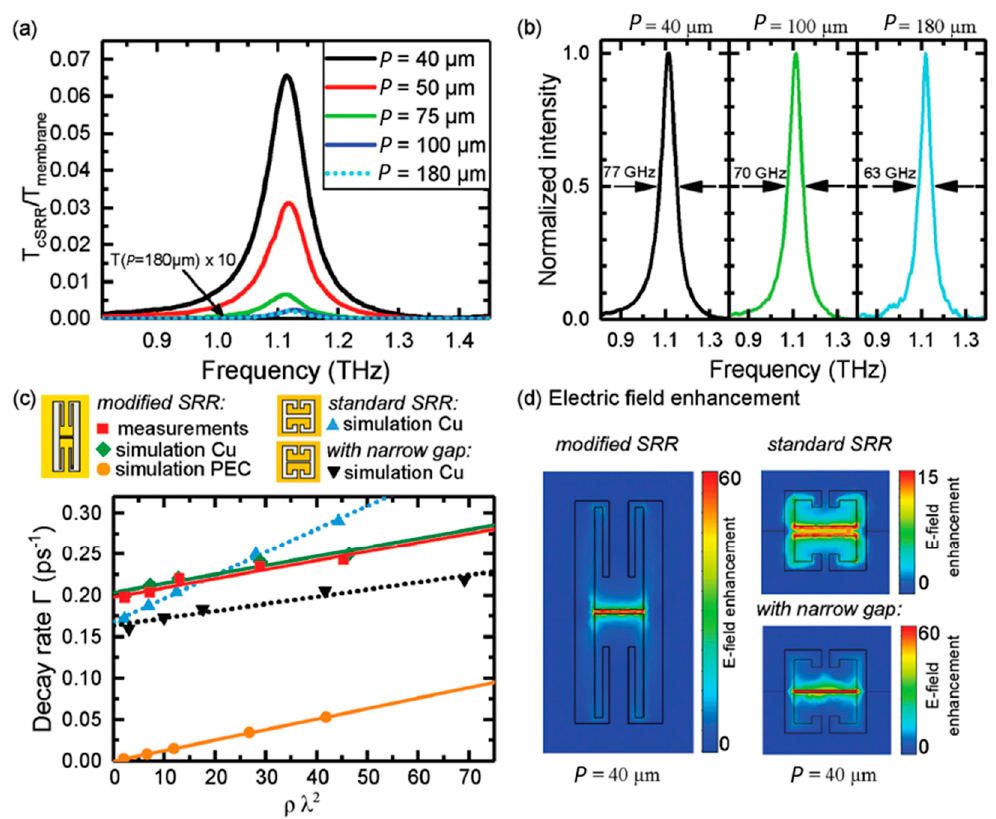
Figure 1. Split ring resonator (SRR) arrays with different packing densities. ( a ) Transmission amplitude of complementary SRR arrays for lattice periods varying from, P = 40 to 180 µ m. Transmission for P = 180 µ m is multiplied by 10 to be visible on the same scale. ( b ) Normalized intensity transmission spectra for P = 40,100 and 180 µ m with their respective full width at half maximum. ( c ) The decay rate Γ as a function of the resonator density ρ multiplied by the square of the wavelength λ for the measured sample and simulations for three SRR geometries [see panel ( d )]. Measurements are for a Si-membrane with Cu resonators and simulations assume a conductivity of 2.5 × 10 7 S m − 1 for copper or a perfect electric conductor (PEC) as indicated. ( d ) Simulated electric field enhancements for P = 40 µ m for the three SRR geometries. Adapted with permission from ref [55], John Wiley and Sons.